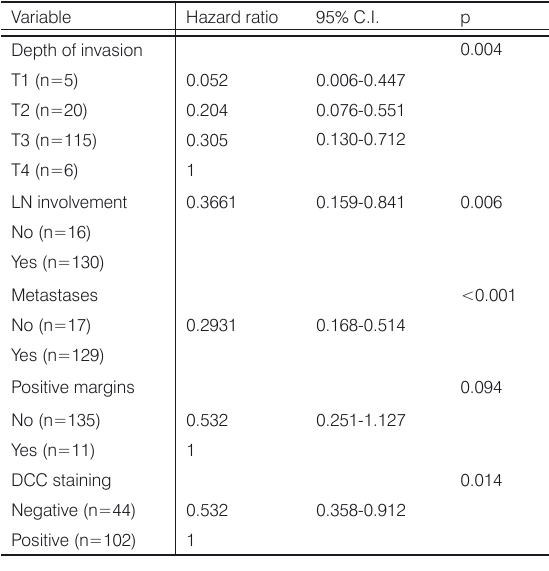
Table 3. Multivariate analysis in relation to overall survival in DCC studied patients.